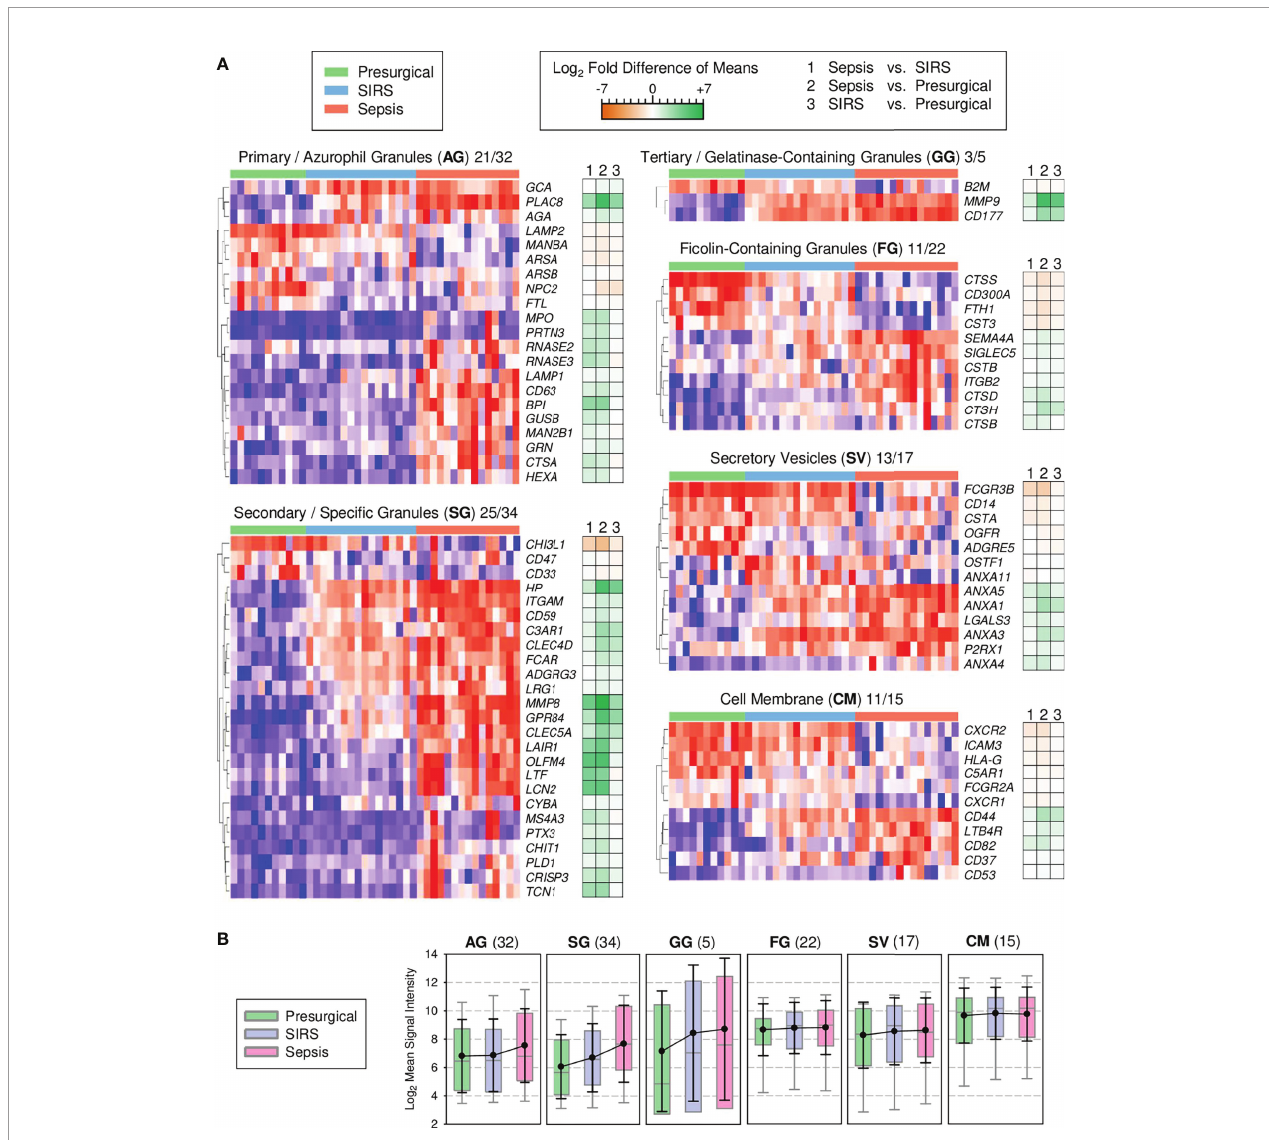
FIGURE 3 | Transcriptional signatures of granule biogenesis in discovery set CD15 + cells (presurgical, n = 11; SIRS, n = 16, sepsis, n = 15). (A) Heat maps for granule signature genes with differential expression by subcellular compartment. Following the two-letter abbreviations for the compartments, the numbers of the shown signature genes and the full numbers of signature genes per compartment are indicated. Tiles are arranged by patient group and genes are hierarchically clustered. Blue indicates the minimum and red maximum expression. Corresponding differences of means for the three patient group comparisons are displayed as accompanying dark orange-green heat maps. (B) Global granule signature gene expression. Patient group means for all signature genes (number in parentheses) are summarized as colored box plots with 5th and 95th percentiles (gray whiskers) and overlaid with the global averages as black dots with standard deviations (black